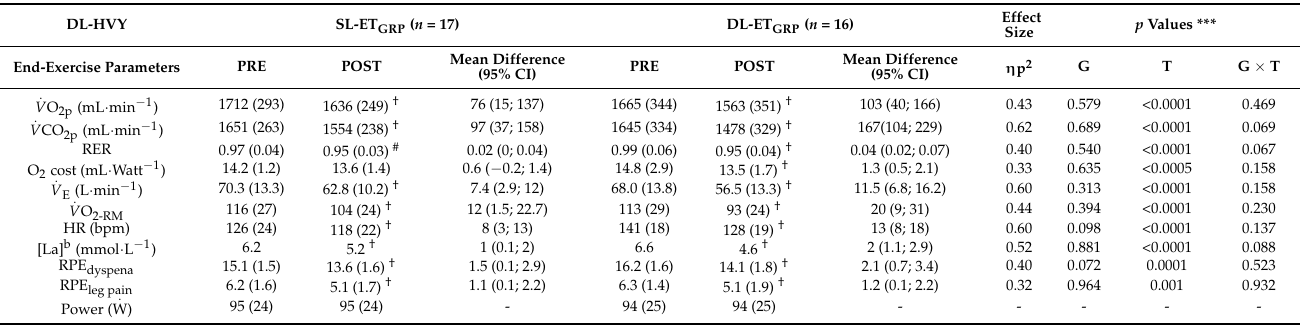
Table 5. Main cardio-respiratory parameters assessed during double leg heavy constant load exercise (DL-HVY) before (PRE) and after (POST) endurance training period. Single leg endurance training group (SL-ET GRP ) and double leg endurance training group (DL-ET GRP ) groups. SL-ET GRP ( n =17) DL-ET GRP ( n =16) Effect Size p